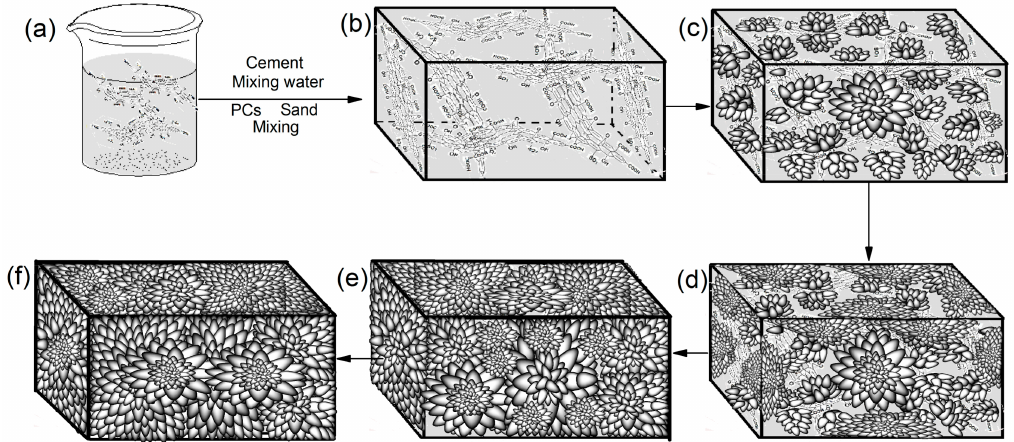
Figure 7. Forming mechanism of regular-shaped cement hydration crystals and compact microstructure. ( a ) CCS/GO intercalation composites; ( b ) Few-layered GO nanosheets uniformly distributed in